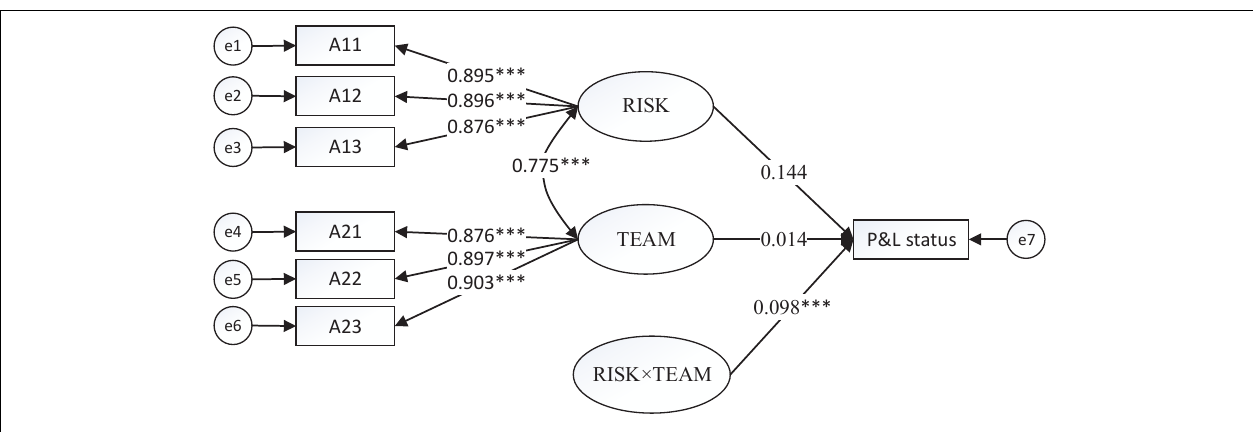
FIGURE 2 | Moderating effect of TEAM on P&L. ∗∗∗ p < 0.001.